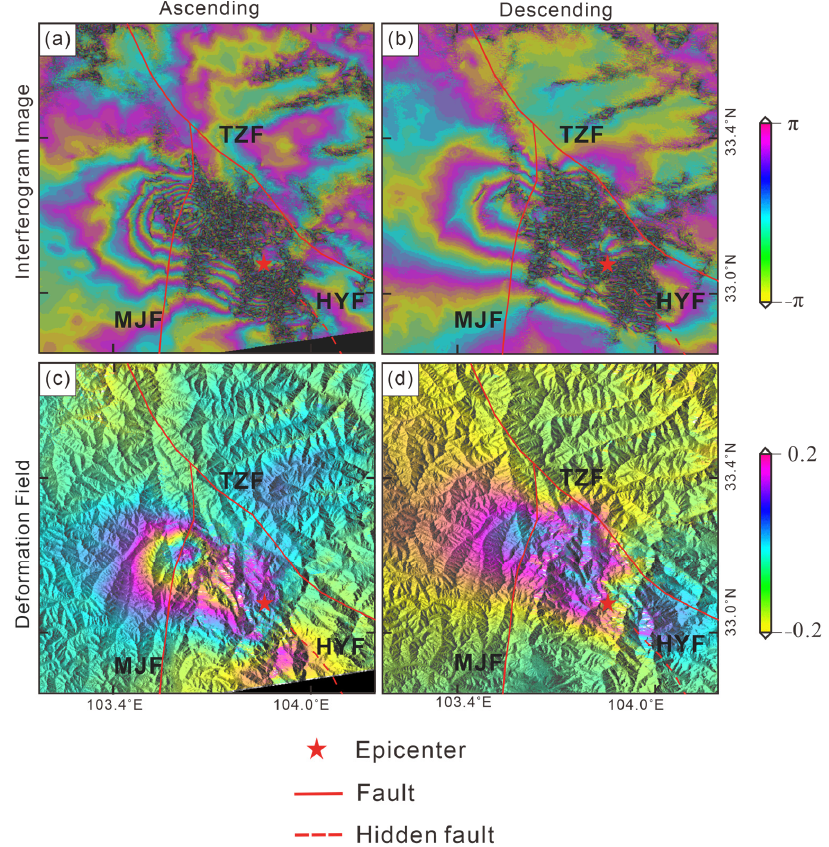
Figure 6. Interferogram image and deformation field of the Jiuzhaigou earthquake. Panels ( a ) and ( b ) are interferogram images of InSAR along ascending and descending orbits, respectively; ( c ) and ( d ) represent the deformation fields of InSAR along ascending and descending orbits, respectively.